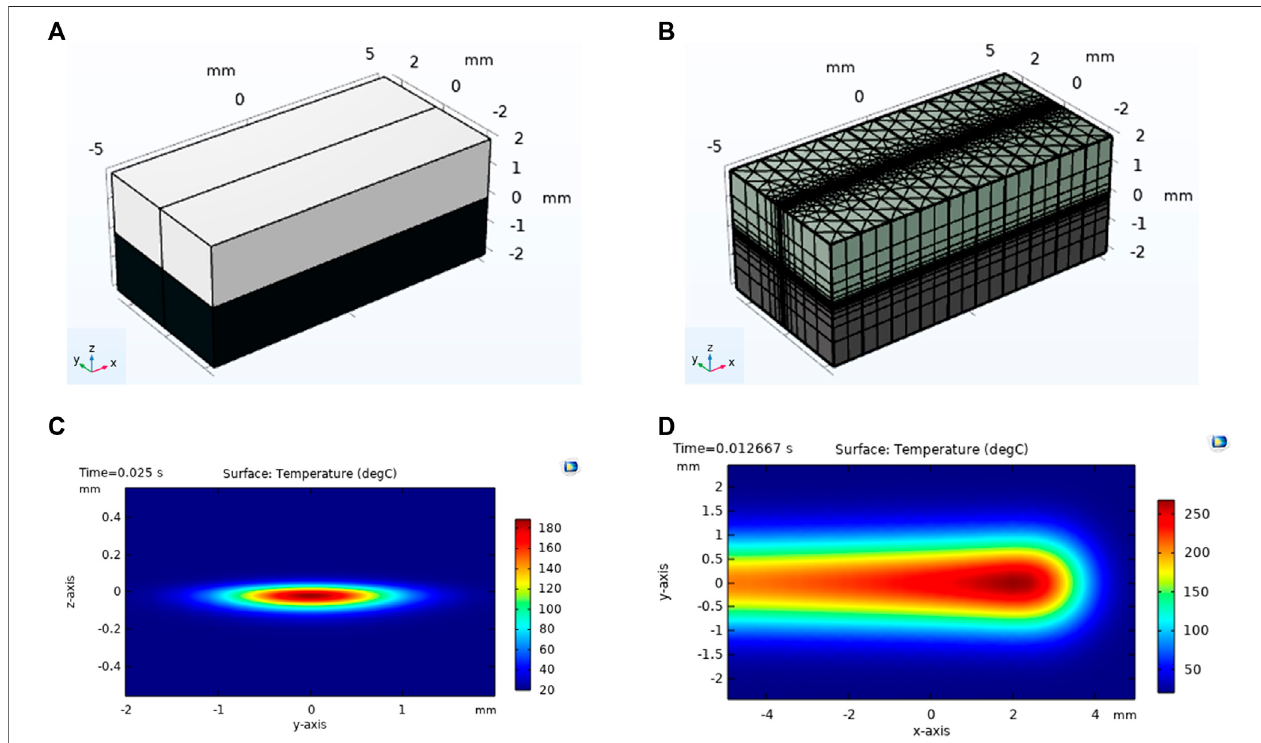
FIGURE5|(A) SchematicsofthetransmissivePPandabsorptivePPwithwt%CBwiththelappedportion, (B) illustrationofnon-uniformmeshpatternusedforthe geometrical model, (C) thermal pro fi le (temperature) of (0, y, z) plane during LTW at t (cid:1) 0.025 s, (d) thermal pro fi le (temperature) of (x, y, 0) plane during LTW at t (cid:1) 0.0127 s simulated for the absorptive layer of 0.5 wt% CB/PP for p (cid:1) 100 W, speed (cid:1) 1,200